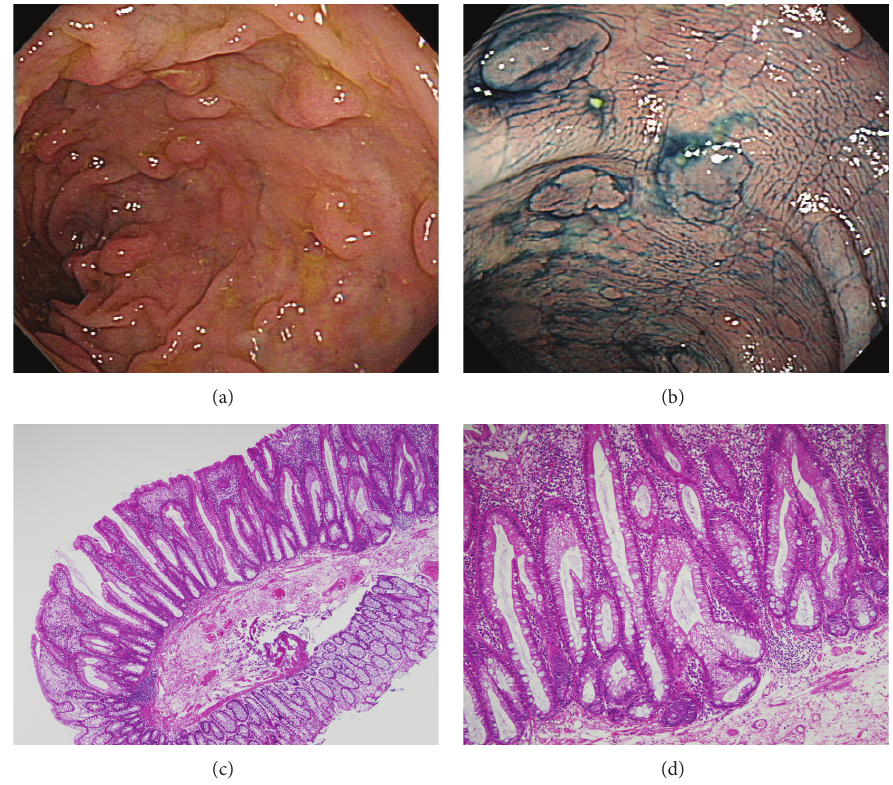
Figure 1: Representative example of serrated polyposis syndrome from patient number 1. Endoscopic findings showing multiple polyps in the sigmoid colon (a), endoscopic findings after indigo carmine spray (b), and histologic findings showing distorted and dilated crypts at the base along with excess serration near the base, original magnification × 10 (c) and × 100